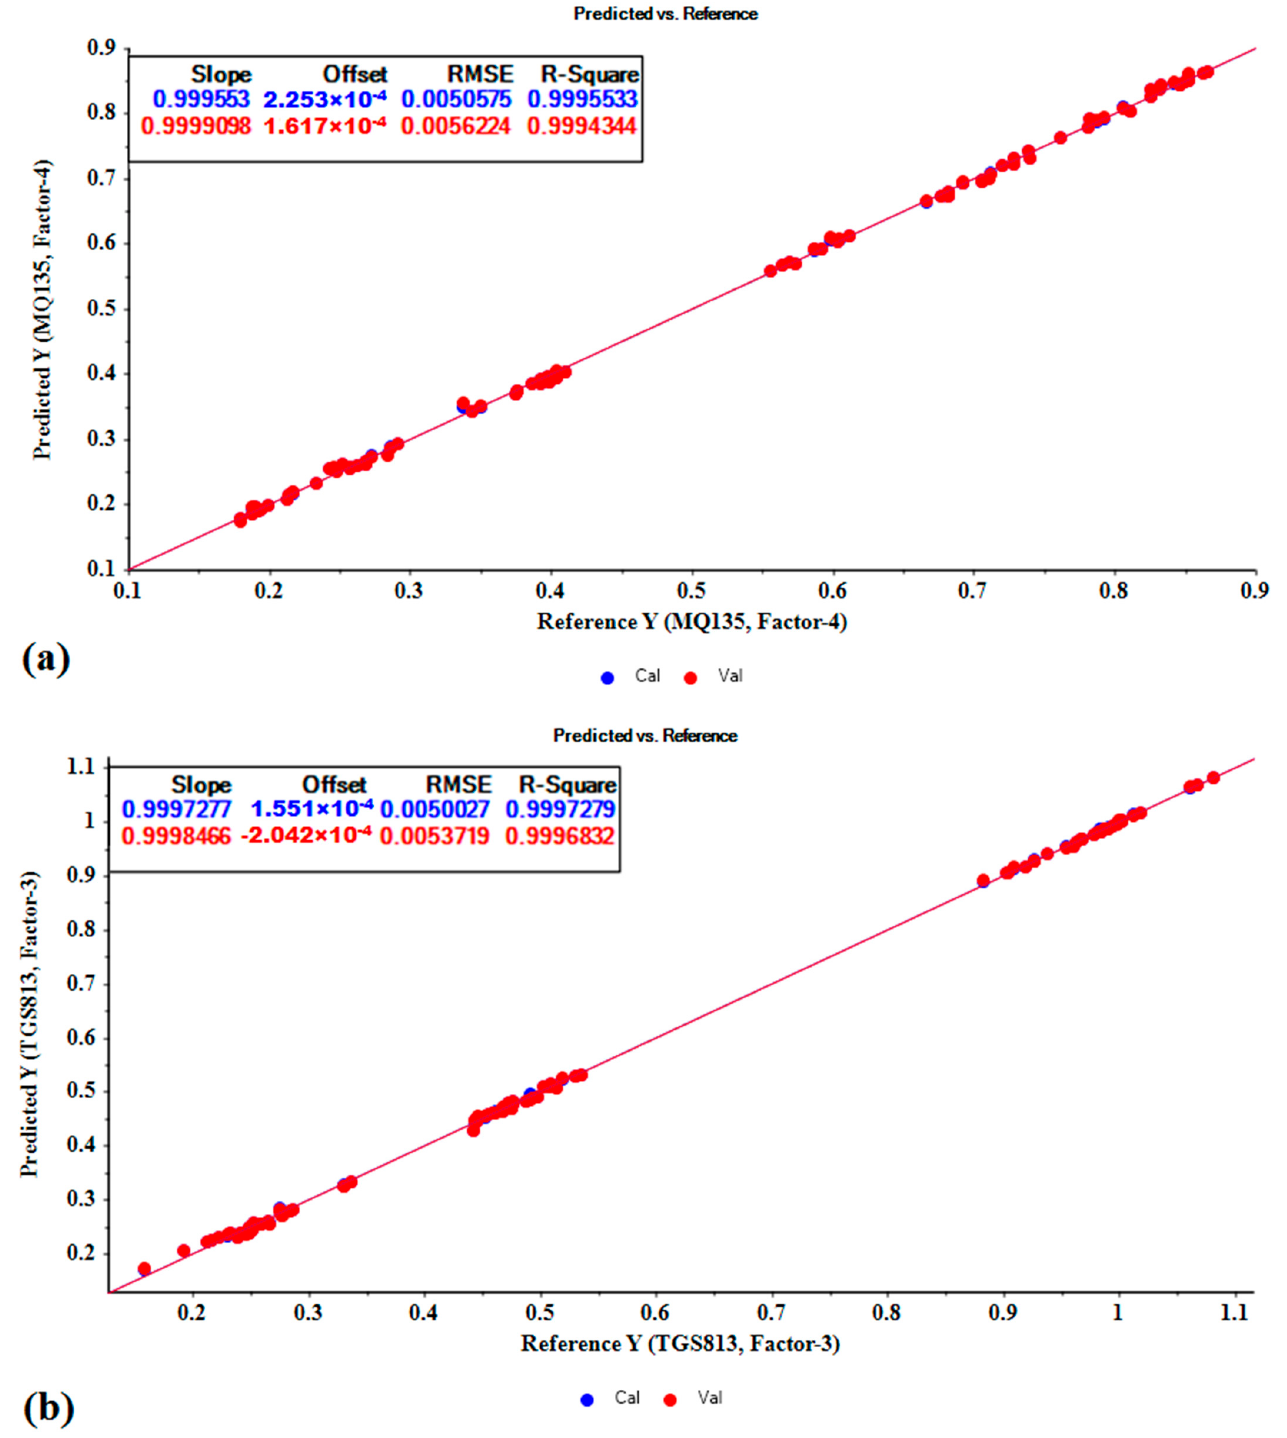
Figure 4. High performance of individual sensors with potential for classifying and differentiating between VOC emissions from different essential oil sample types. Linear correlation of predicted vs. actual (reference) sample classification by the best high performing and most discriminating individual sensors from the MAU-9 sensor array: ( a ) Sensor MQ135 and ( b ) Sensor TGS813 with associated linear regression statistical analysis results displayed for each sensor.